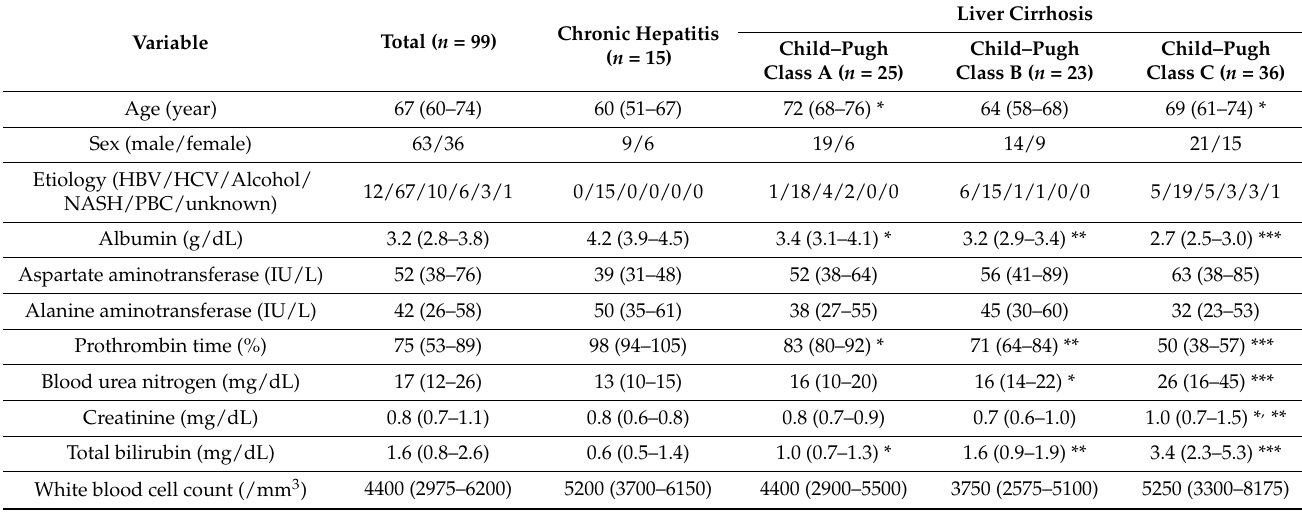
Table 1. Characteristics of patients with liver